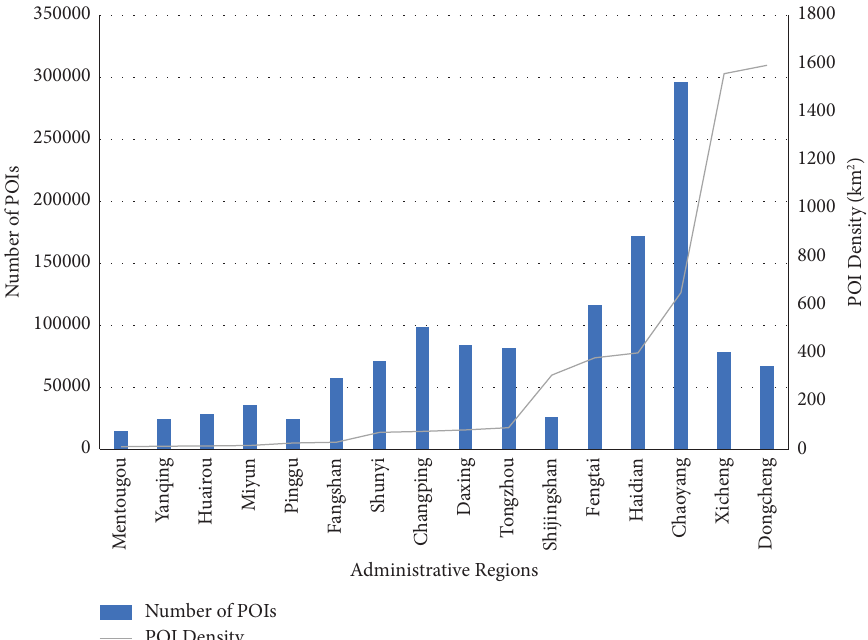
Figure 3: POI distribution by administrative regions in Beijing.